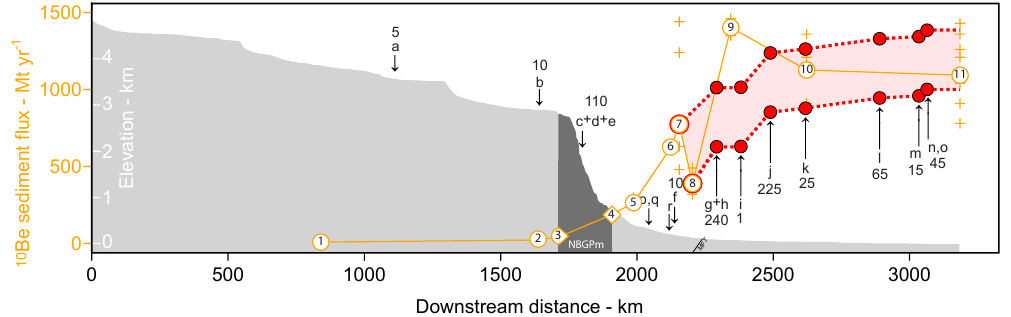
Figure 10. Evolution of the 10 Be-derived sediment flux as a function of distance along the Tsangpo-Brahmaputra trunk stream along with the channel elevation profile in grey. The arrows show the addition of sediments from tributaries along with their 10 Be-derived sediment addition in megatons per year. The red curves show the evolution of the total sediment flux that is obtained by adding the 10 Be-derived sediment flux of tributaries (g–o) to the Tsangpo-Brahmaputra sediment flux measured at the front of the Himalayan range (with a flux of 770Mtyr − 1 at pt. 7 or 390Mtyr − 1 at pt. 8). The sediment flux at pts. 10 and 11 is compatible with the addition of sediment from tributaries (i.e., within the range of the red curve); the sediment flux measured at pt. 9 exceeds these